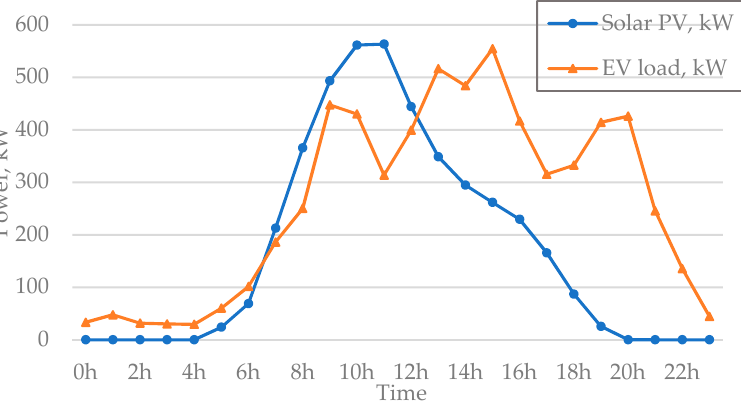
Figure 2. Solar PV and EV arrival (load) in kW.